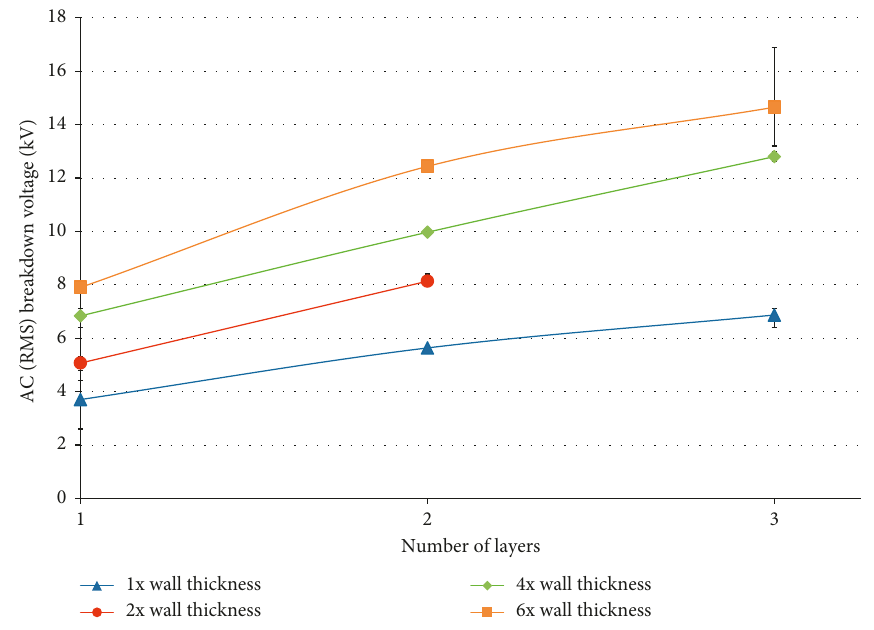
Figure 5: AC (RMS) breakdown voltages of small scale samples in LN